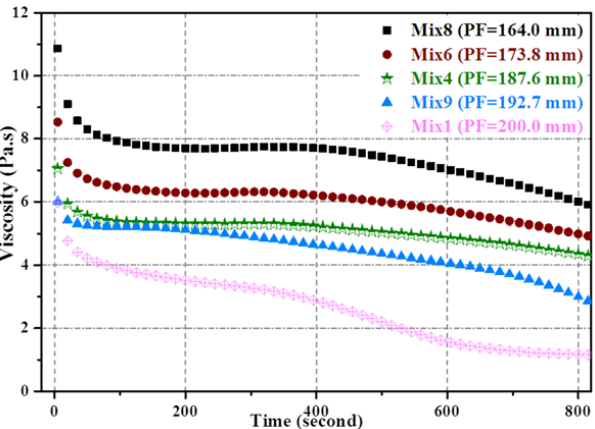
Materials 2022 , 15 , x FOR PEER REVIEW Figure 7. The viscosity of cement paste. Figure 7. The viscosity of cement paste.